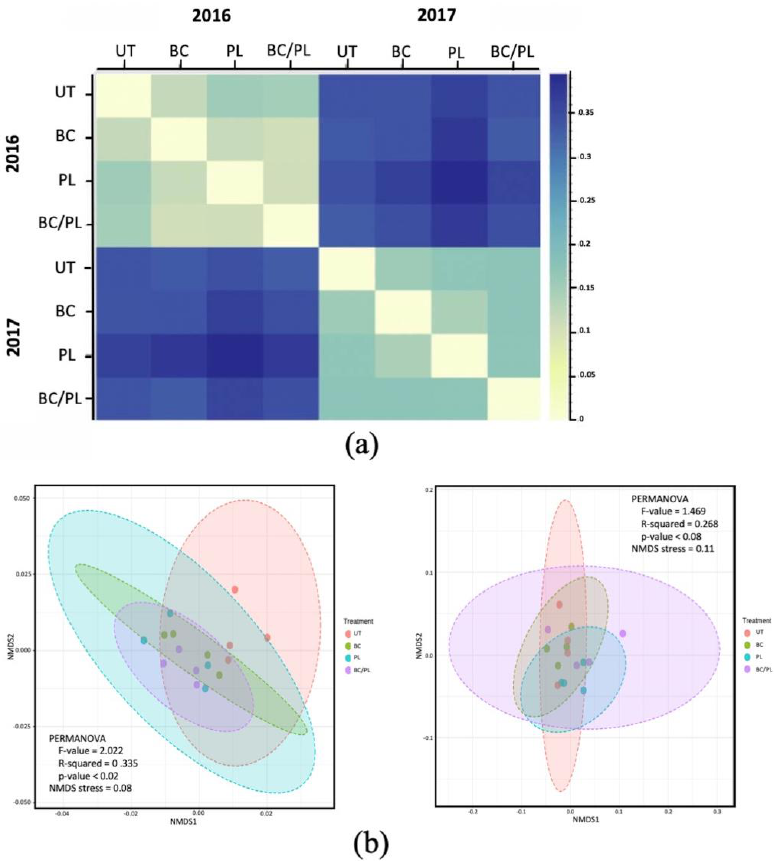
Figure 1. The beta diversity among soils treatments in 2016 and 2017. ( a ) A Bray-Curtis dissimilarity heatmap of the community structure and membership at the genus level among the treatments. ( b ) Non-metric multidimensional scaling (NMDS) plots with weighted Unifrac distances among soil treatments: untreated (UT), biochar (BC), poultry litter (PL), and a combination of biochar and poultry litter (BC/PL). Fields that overlap ordination space have similar community composition. Plot ellipses represent the 95% confidence regions per